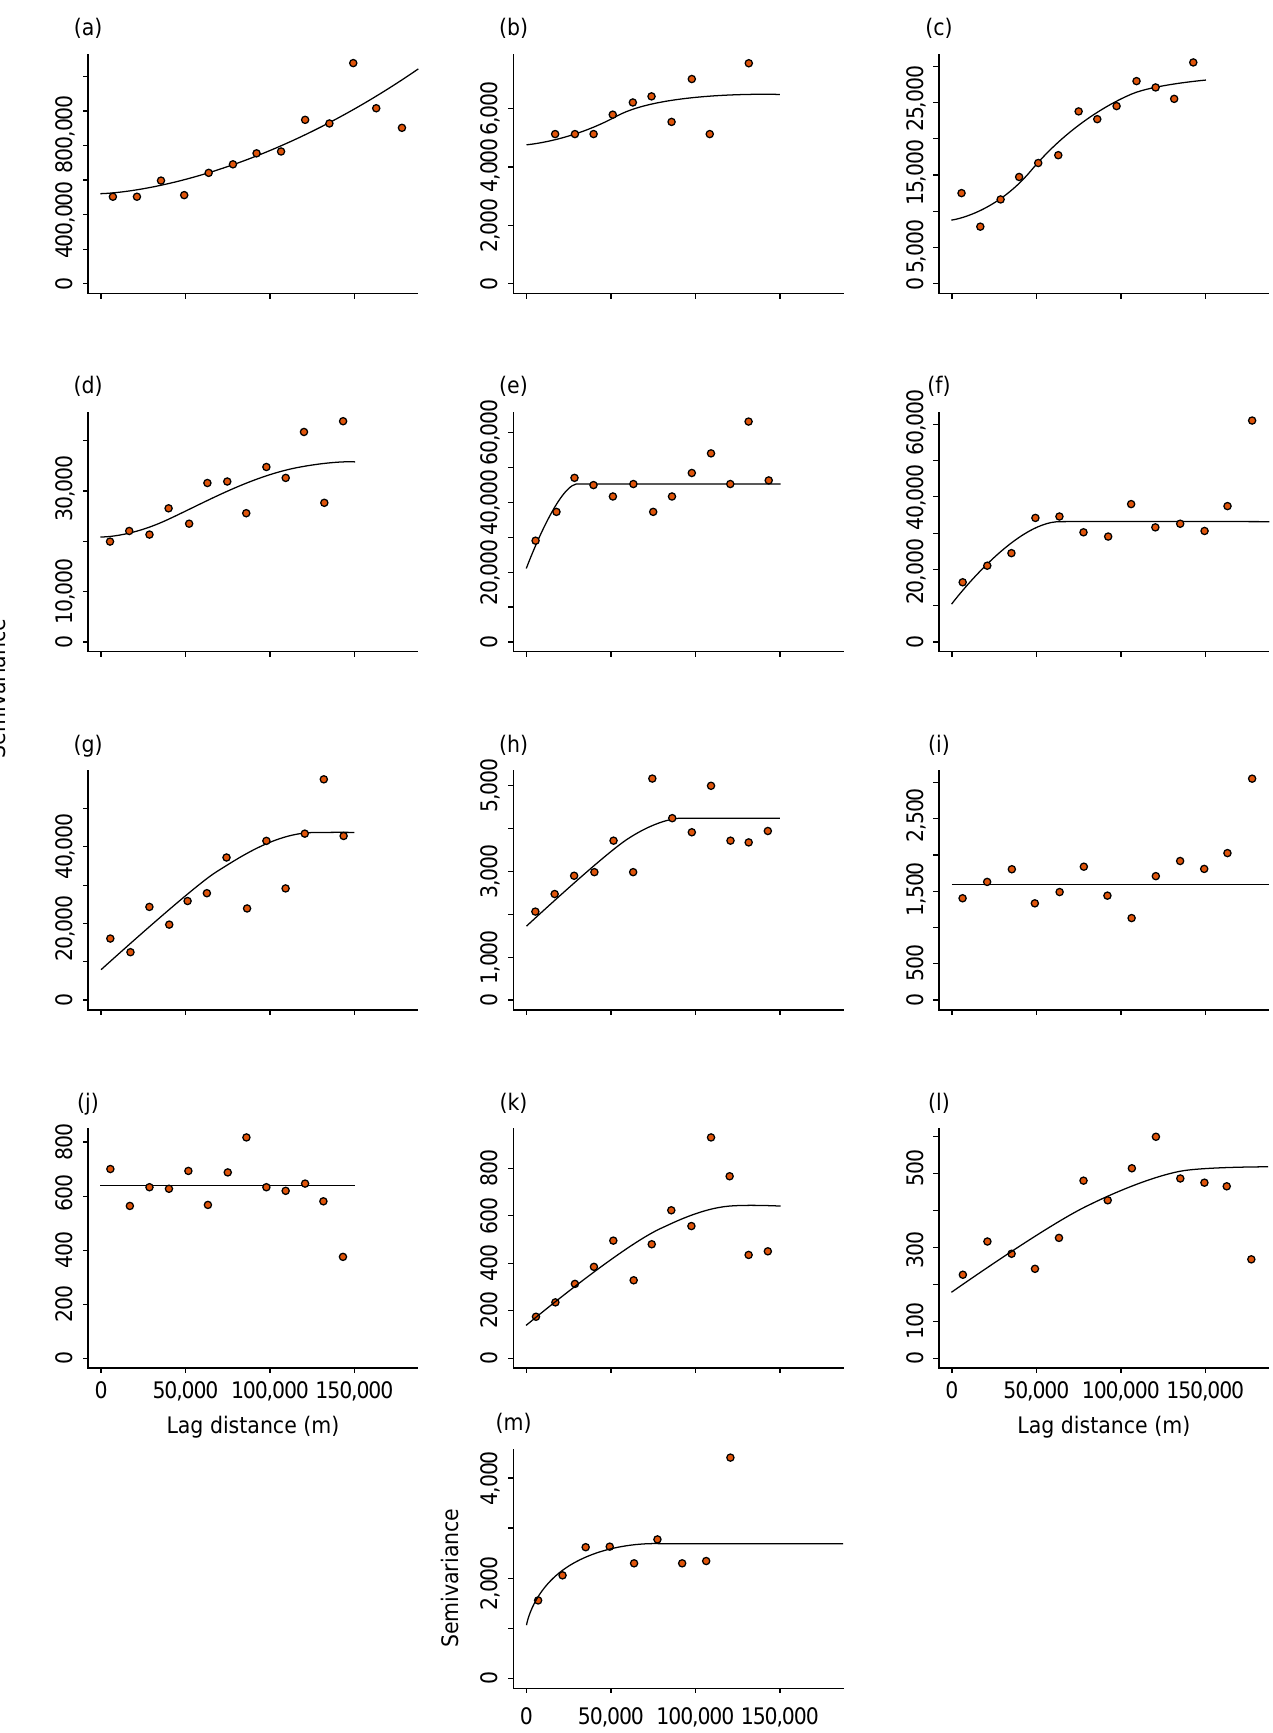
Figure 3. Residual semivariograms for the annual mean (a), and for the months of October (b), November (c), December (d), January (e), February (f), March (g), April (h), May (i), June (j), July (k), August (l), and September